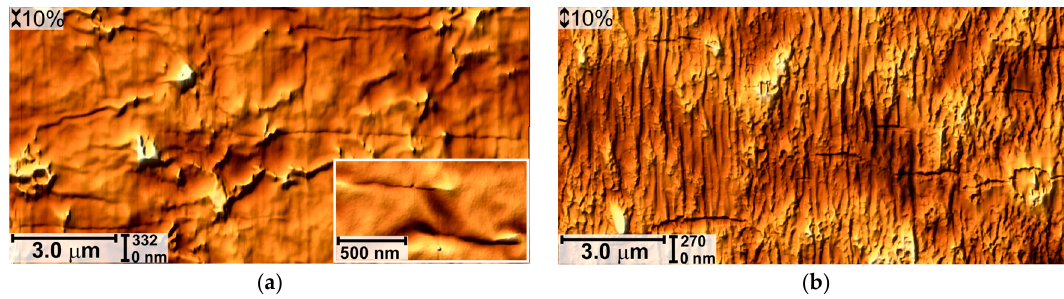
Figure 6. AFM images of PU after the PIII 1-17 and fatigue loading to 10% in the unloaded state ( a ) the closed cracks are visible, which are open in stretched state ( b ).